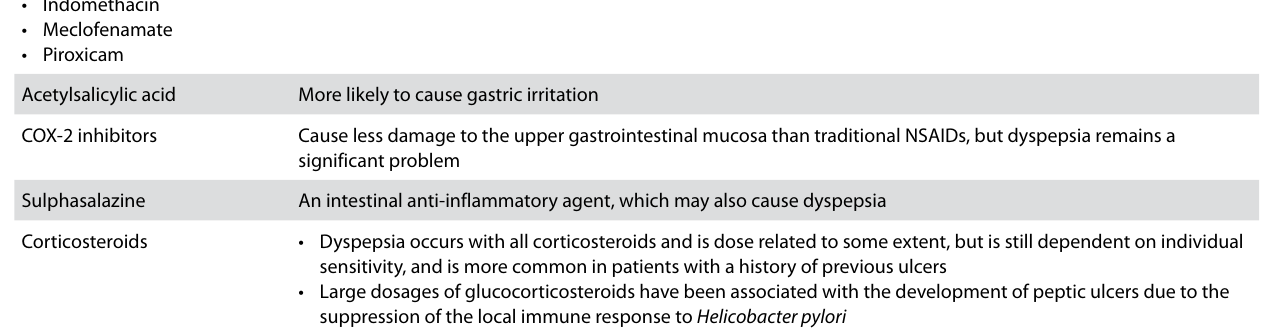
Pain and fever, and anti-inflammatory